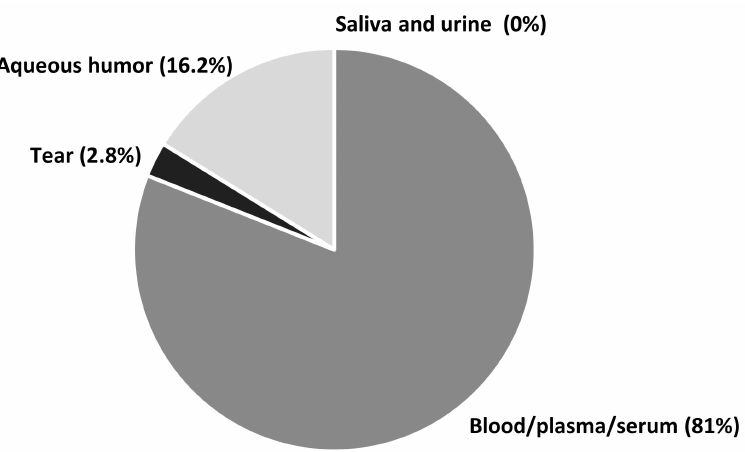
Figure 2. Types and frequency of biological material used for the analysis of potential glau- coma